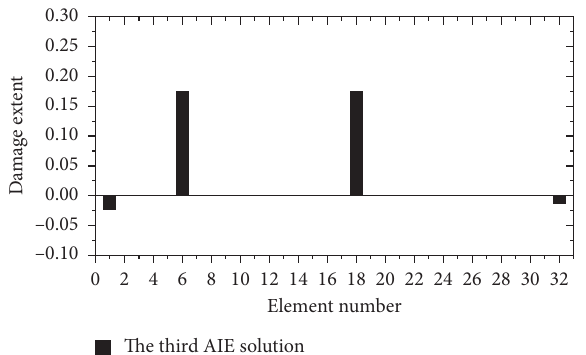
Figure 9: Damage assessment result by the third AIE when elements 6 and 18 are damaged.